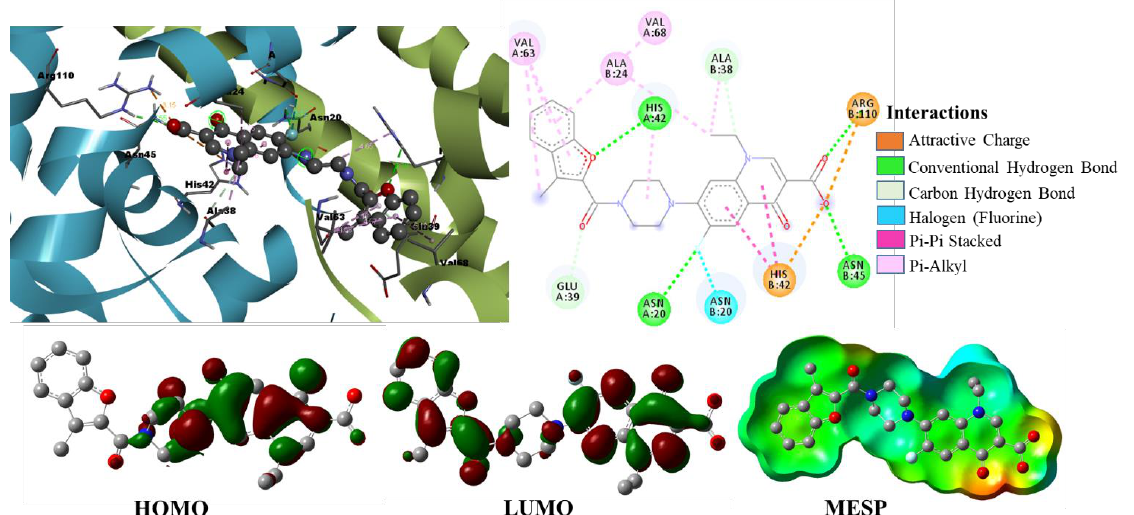
Figure 7. Binding mode conformation and molecular interactions of hit compound ZINC09550296 in the active site of S. epidermidis TcaR. The left and right figures represent the molecular interactions in 3D and 2D, respectively. The hit compound is shown in the ball-stick model, and the key interacting residues are shown as grey sticks.